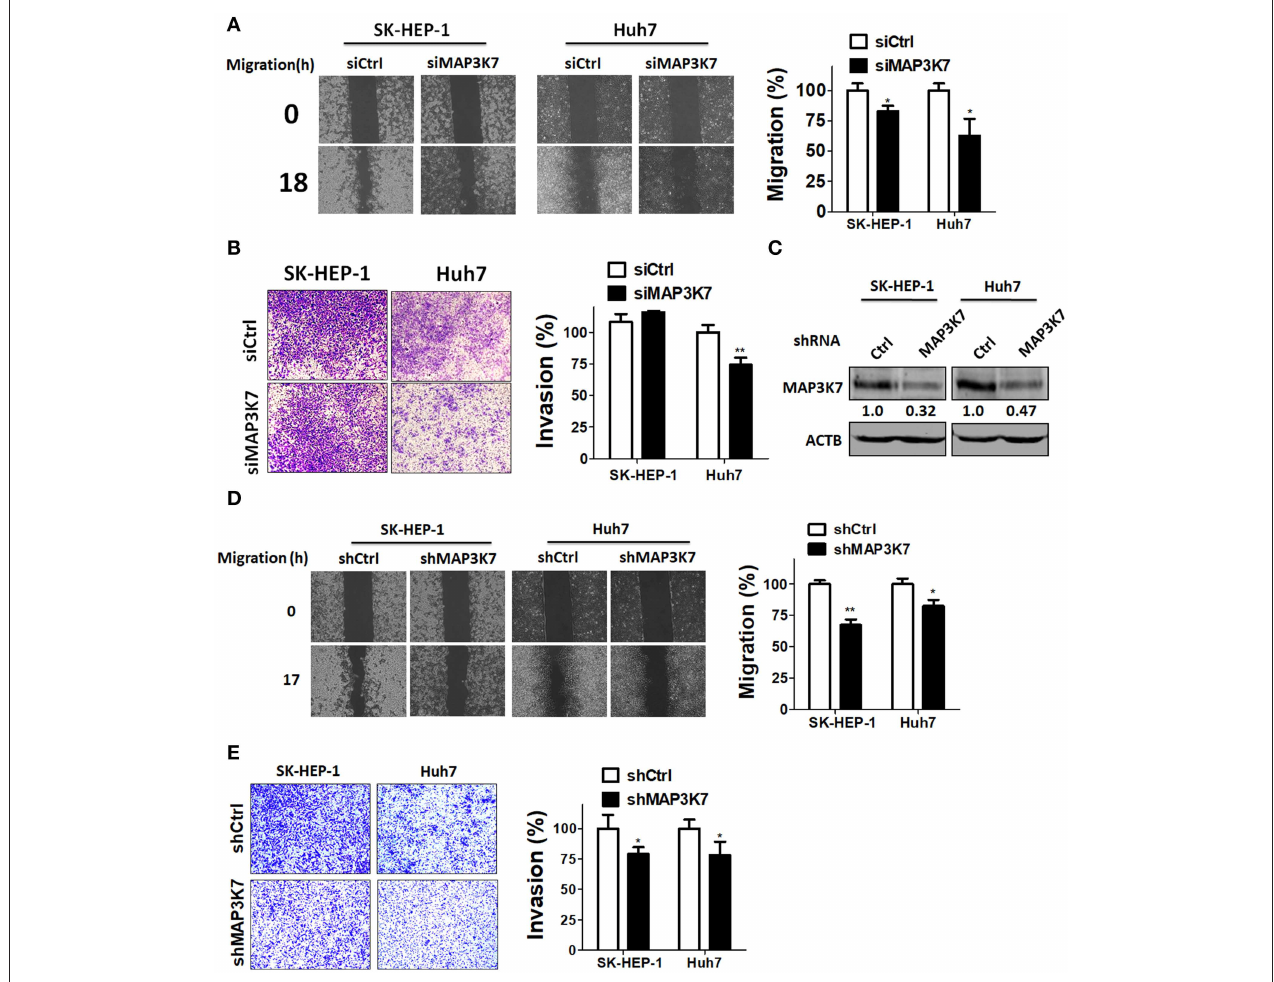
FIGURE 2 | Effects of MAP3K7 on HCC cell migration and invasion. (A) Scramble siRNA (5nM) or siRNA against MAP3K7 was transfected into SK-HEP-1 and Huh7 cells for 48h. A cell migration assay was performed using a culture insert for control and MAP3K7-silenced HCC cells (left panel). The migratory distance of HCC cells was quantified with ImageJ software in the right panel. (B) The invasion of HCC cells transfected with scramble or siRNA against MAP3K7 was examined with Matrigel-coated Transwell filters. The cell invasion results were quantified with ImageJ software in the right panel. (C) Stable knockdown efficiency of MAP3K7 in SK-HEP-1 and Huh7 was confirmed by immunoblotting. (D) A cell migration assay and (E) invasion assay for stably knocked down HCC cells were performed. The quantified results for migration (D) and invasion (E) are showed in the right panel as the mean ± SEM from three independent experiments. * p < 0.05; ** p <